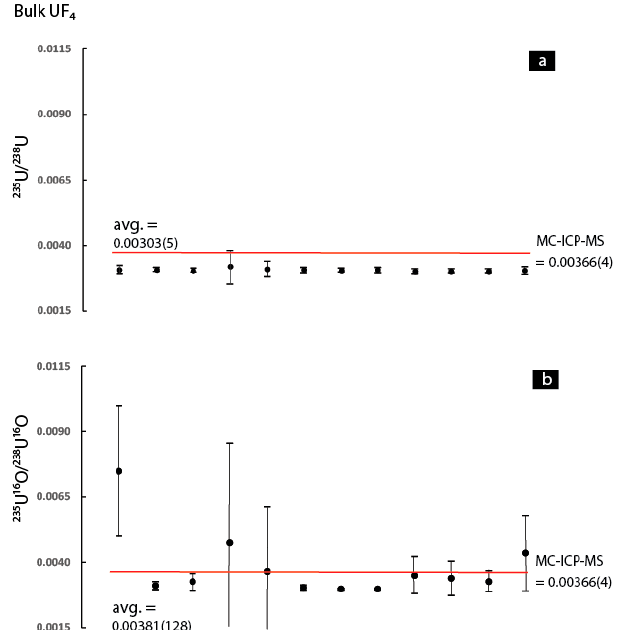
Figure 7. Plot of each analysis’s ( a ) 235 U / 238 U and ( b ) 235 U 16 O / 238 U 16 O ratio and its associated 1 σ uncertainty, relative to the solution MC-ICP-MS value (red line), for the UF 4 .